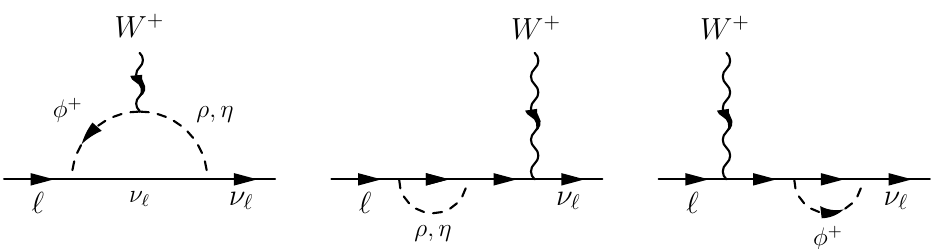
Figure 3 . Feynman diagrams of the loop corrections to charged lepton currents